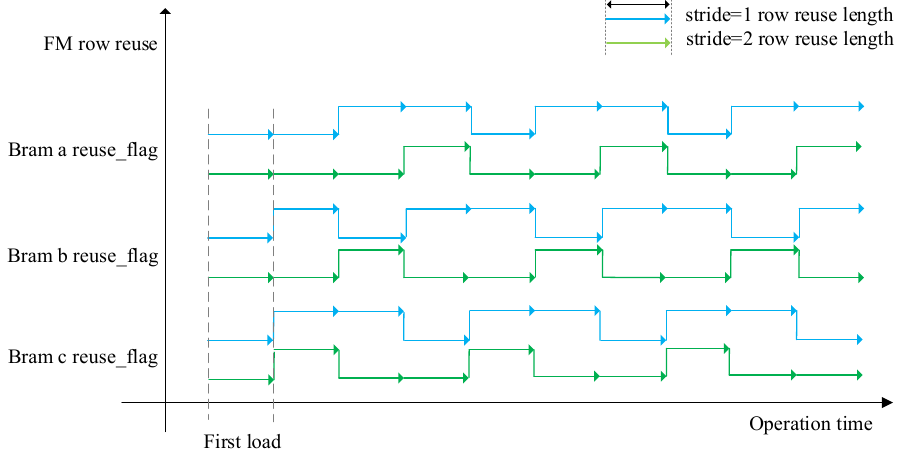
Figure 10. Schematic diagram of row reuse logic design of feature map.